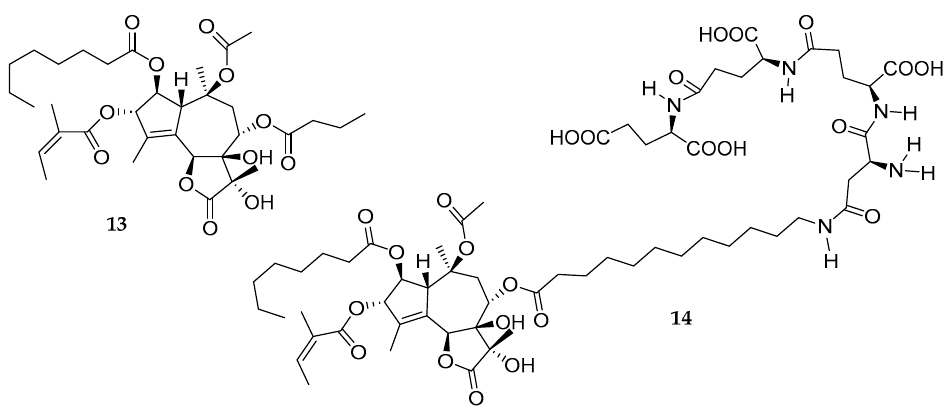
Figure 10. Structure of thapsigargin ( 13 ) and its derivative mipsagargin ( 14 ).